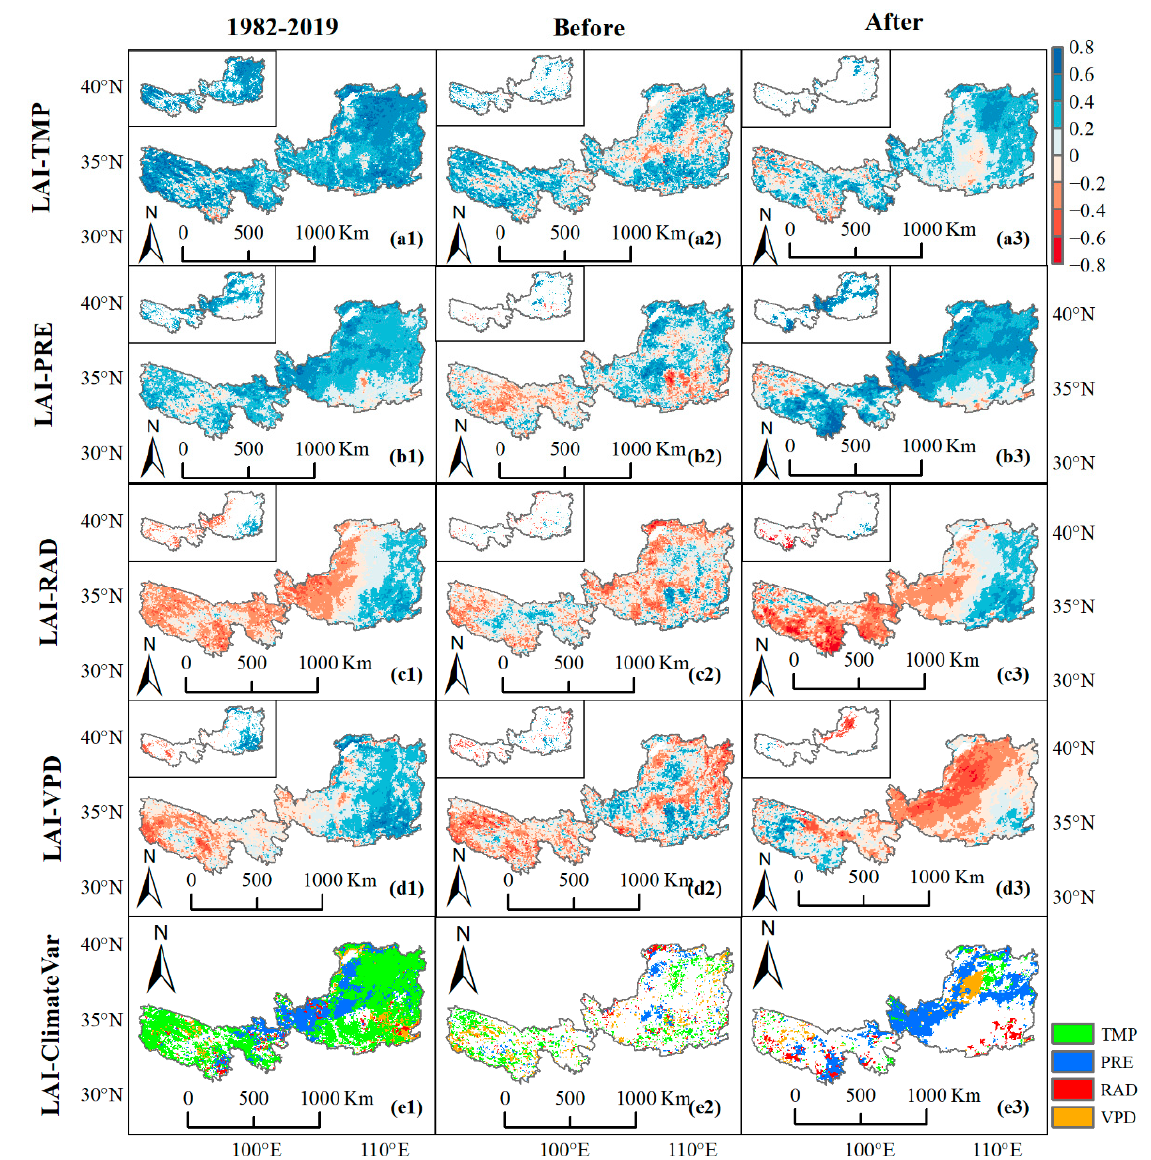
Figure 6. Spatial patterns of the correlation coefficients between LAI and TMP (first column), PRE (second column), RAD (third column), VPD (fourth column), and spatial patterns of dominant climatic constraint on LAI (fifth column). They were estimated for 1982–2019 ( a1 – e1 ), before the implementation of the ecological engineering project ( a2 – e2 ), after the implementation of ecological engineering ( a3 – e3 ), respectively. TMP, PRE, RAD, and VPD represent temperature, precipitation, downward surface shortwave radiation, and vapor pressure deficit, respectively.